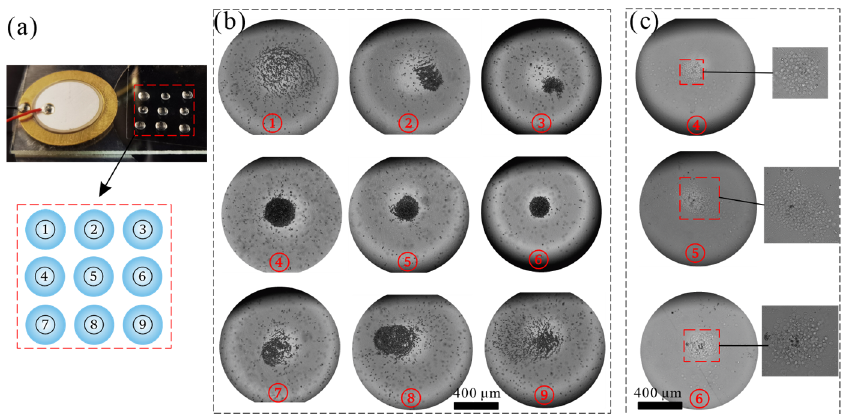
Figure 7. Simultaneously concentration of 10 μ m particles and cells in multiple sessile droplets. ( a ) Photograph image of the chip and numbered diagram of droplets. ( b ) The effect of particle concentration in nine droplets at 200 s. ( c ) Concentration effect of liver cancer cells in three droplets.